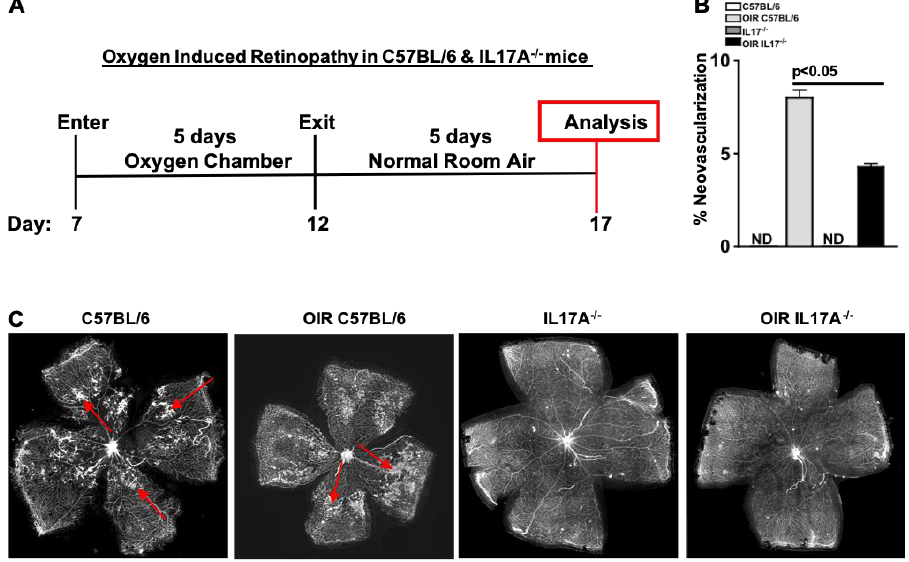
Figure 5. Retinal Neovascularization is Decreased in IL17A -/- Mice with Oxygen-Induced Retinopa- thy. ( A ) Schematic of the murine model of oxygen induced retinopathy and retinal neovascularization. ( B ) Quantification of neovascularization in C57BL/6 and IL17A -/- mice (n = 5/group). ( C ) Representative images of neovascularization in retina whole mounts. Red arrows highlight neovascularization. ND = not detected. Error bars represent the SEM. The p -value was first equated by two-way